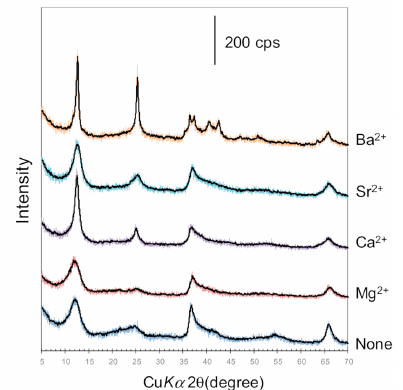
Figure 6. Illustration of the two-step extraction of Ba 2+ and Mn from the newly formed biogenic manganese oxides during repeated treatment with mixtures of 10 mM Ba(NO 3 ) 2 , Sr(NO 3 ) 2 , Ca(NO 3 ) 2 , or Mg(NO 3 ) 2 with 1 mM Mn(NO 3 ) 2 in 20 mM HEPES (pH of 7.0). The bathing solutions were renewed thrice every 24 h. The conversion (%) from Mn 2+ to solid Mn is displayed in the top panel.